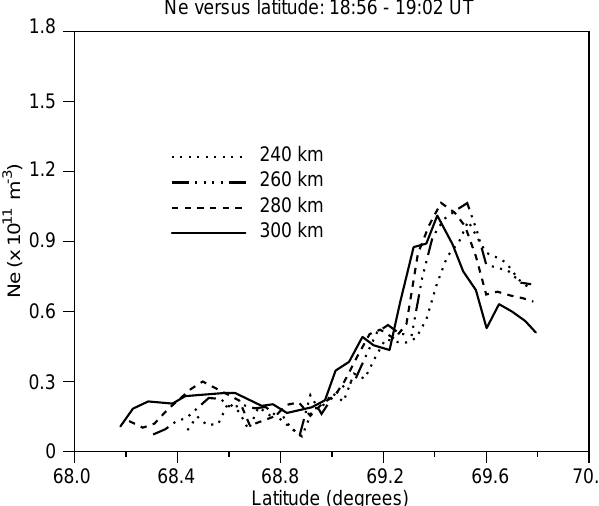
Fig. 4. Electron densities as a function of latitude for four selected heights measured by the radar during the scan commencing at 1856 UT